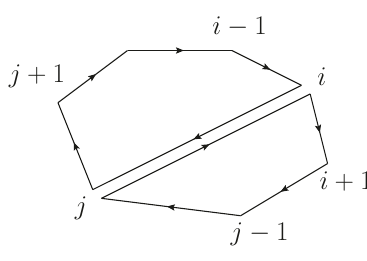
Figure 5 . The three terms in eq. (5.7) correspond to the three polygons on the figure.